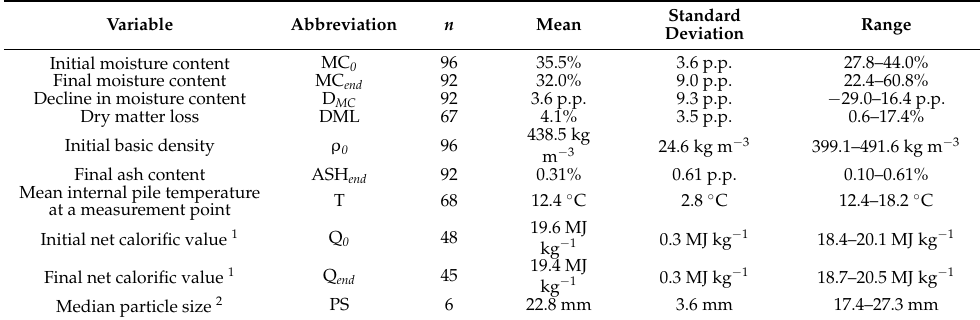
Table 2. Description of the variables used in the analyses. Standard deviations and changes for percentage values are given in percentage points (p.p.).